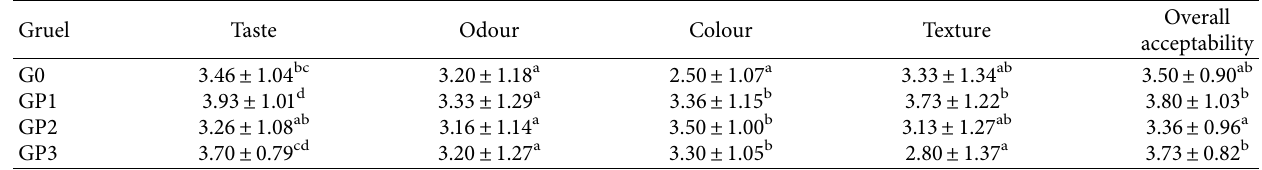
Table 2: Organoleptic characteristics of the fortifed pearl millet gruels. Gruel